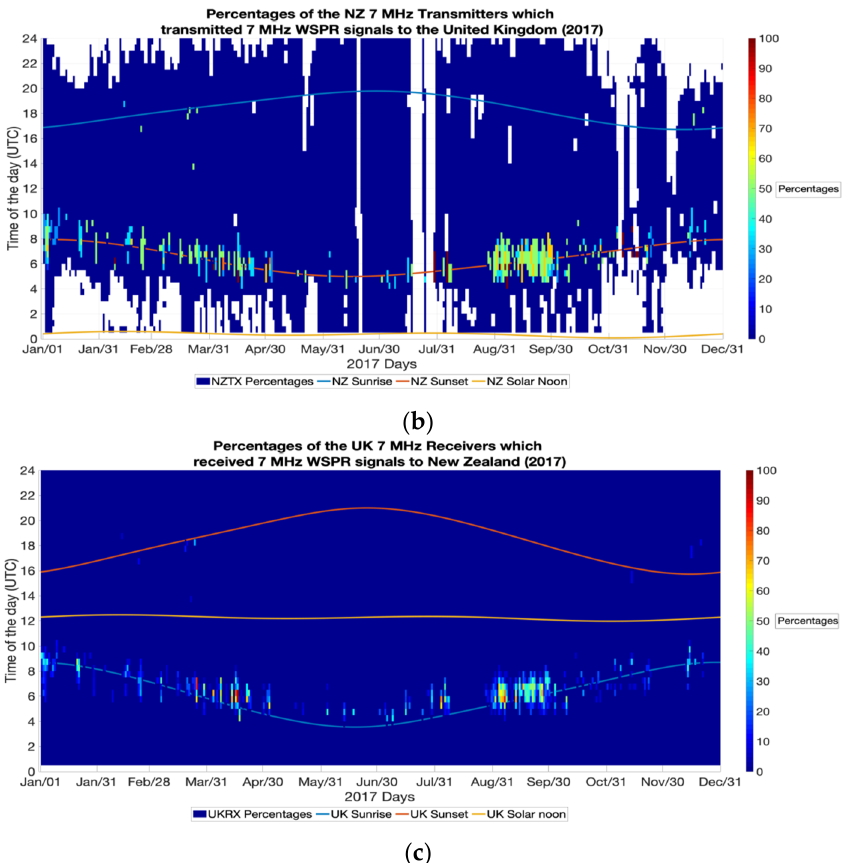
Figure 12. ( a ) The 7 MHz radio links made from New Zealand to the UK in 2017. The blue shaded area is the New Zealand daytime hours. The red area is the UK daytime hours. The yellow shaded area is the common daytime hours, and the white shaded area is the common night hours. The colours indicate the number of links available in each half-hour interval. ( b ) Percentages of active New Zealand WSPR transmitters which have transmitted a link to the UK in 2017. Only transmitters with a proven capability to cover the distance from New Zealand to the UK were considered. The colours indicate the percentage of transmitters available in each half-hour interval. ( c ) Percentages of active UK WSPR receivers which have received a link from New Zealand in 2017. Only receivers with a proven capability to cover the distance from New Zealand to the UK were considered. The colours indicate the percentage of receivers available in each half-hour interval.